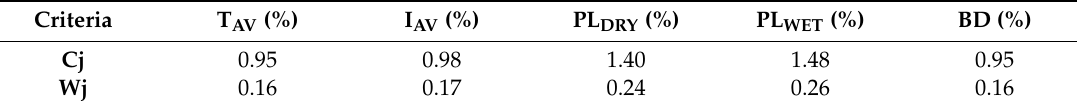
Table 9. Weights assignment for di ff erent